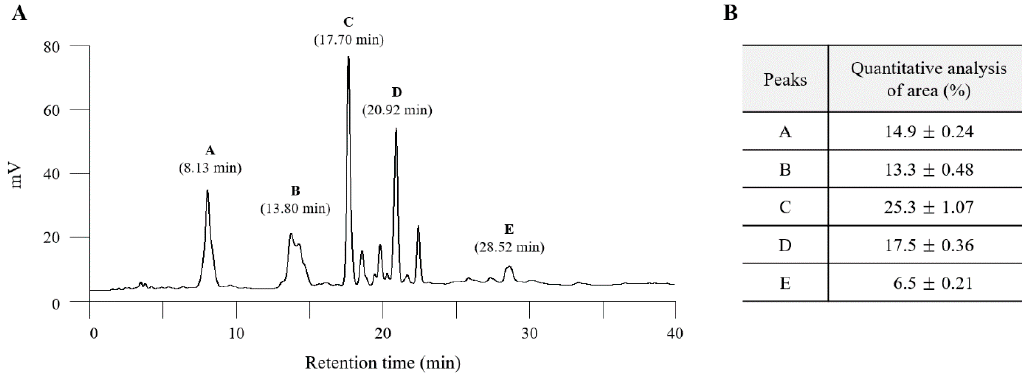
Figure 1. Fingerprinting analysis of the Aquilariae Lignum fraction (ALF). Five peaks were detected at each retention time ( A ), and their areas were semiquantified ( B ). ALF was subjected to UHPLC- MS, and a chromatogram was obtained at a wavelength of 280